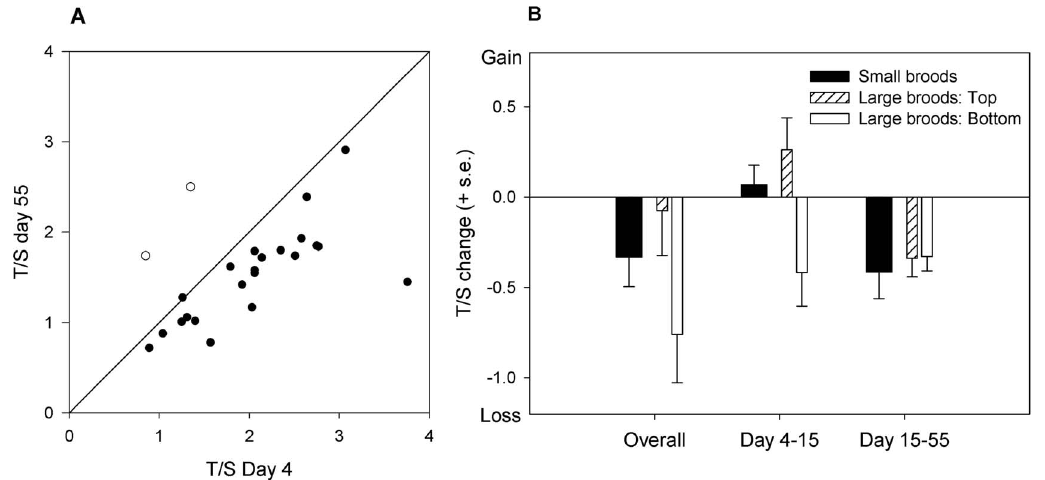
Figure 2. Telomere dynamics in the starlings. A. T/S ratio at day 55 plotted against T/S ratio at D4. Each point represents a bird, and the solid line is y=x. The two birds represented by unfilled circles are the only ones to have lower T/S ratio at day 4 than at both subsequent time points, and are those discussed in the text as outliers. B. Mean T/S ratio change for the study period overall (day 4 to day 55), for the period of the experimental manipulation in the nests (day 4 to day 15), and for the post-manipulation period in captivity (day 15 to 55). Birds from the large broods are sub- divided into those who occupied the first or second place in the within-brood size hierarchy (‘top’) and those who occupied lower positions (‘bottom’).